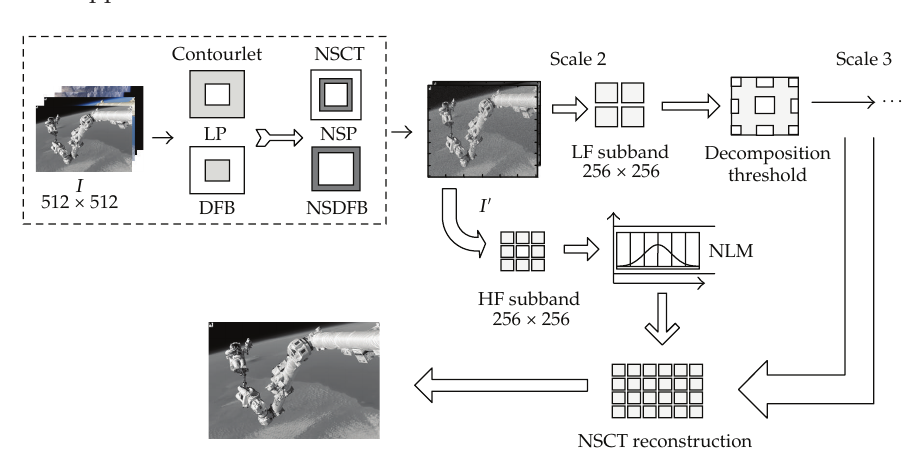
Figure 5: Image feature extraction based on the contourlet